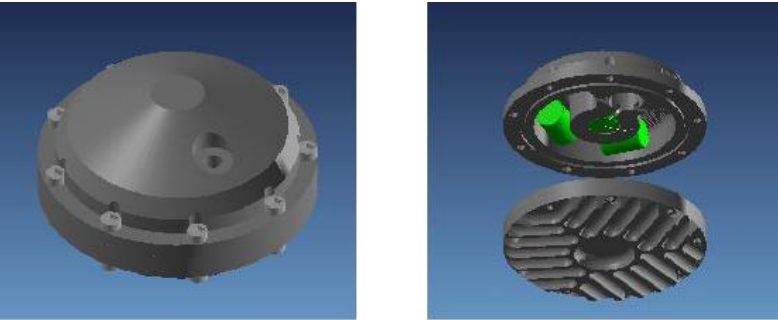
Figure 9. Geophone structure and transversal section where the space for the sensors can be seen. The contours in the base are to improve coupling with seabed mud. Based on a design by Carrack Measurement